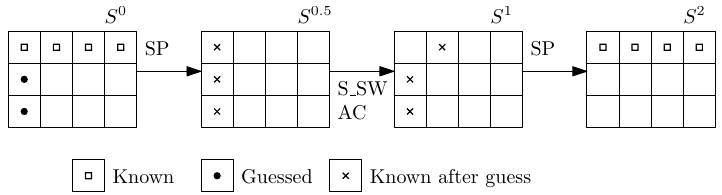
Figure 10: Generate a valid inner part for the preimage attack on 2-round Gimli-Hash Step 1: Choose a random value for S 0 [1 , 2][0] and compute ( S 1 [0][1], S 1 [1 , 2][0]). Check whether ( S 1 [1 , 2][0], S 2 [0][0]) is valid based on Property 2. If it is, store S 0 [1 ,